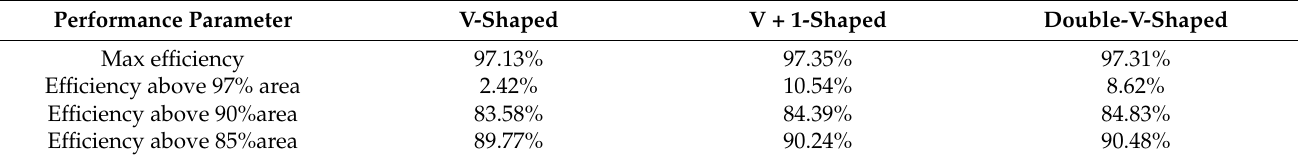
Table 7. Summary of different performance parameters.